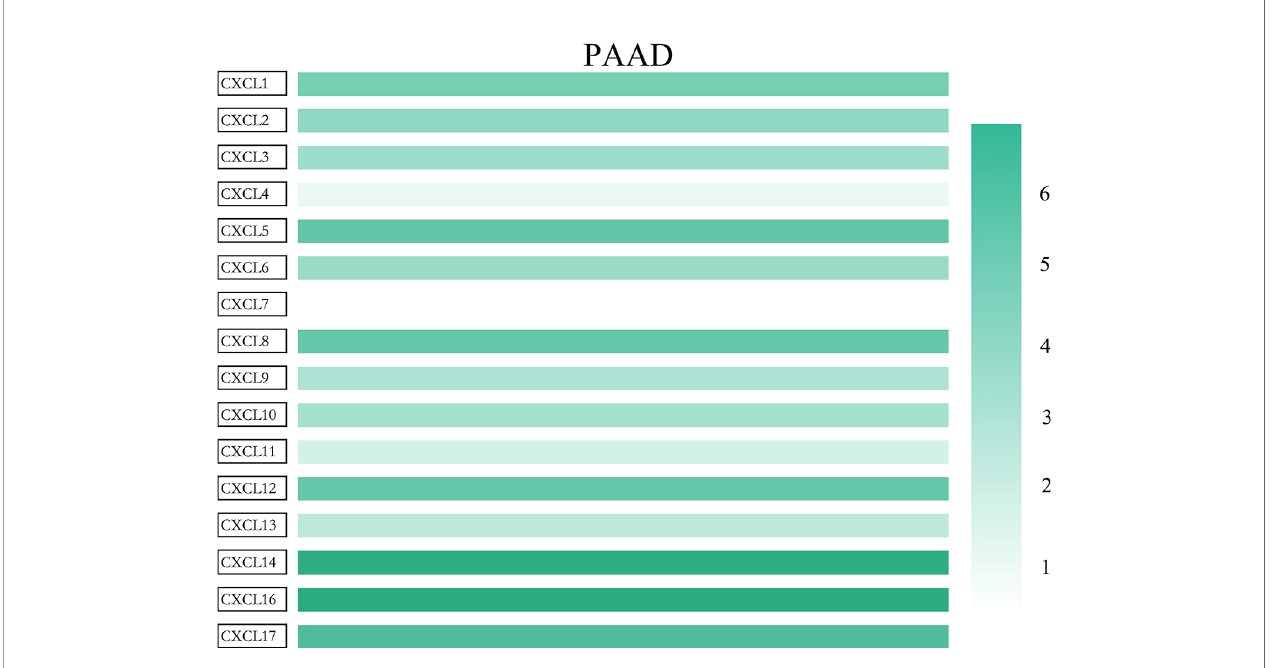
FIGURE 3 | The relative expression level of CXC chemokine family members in LUAD